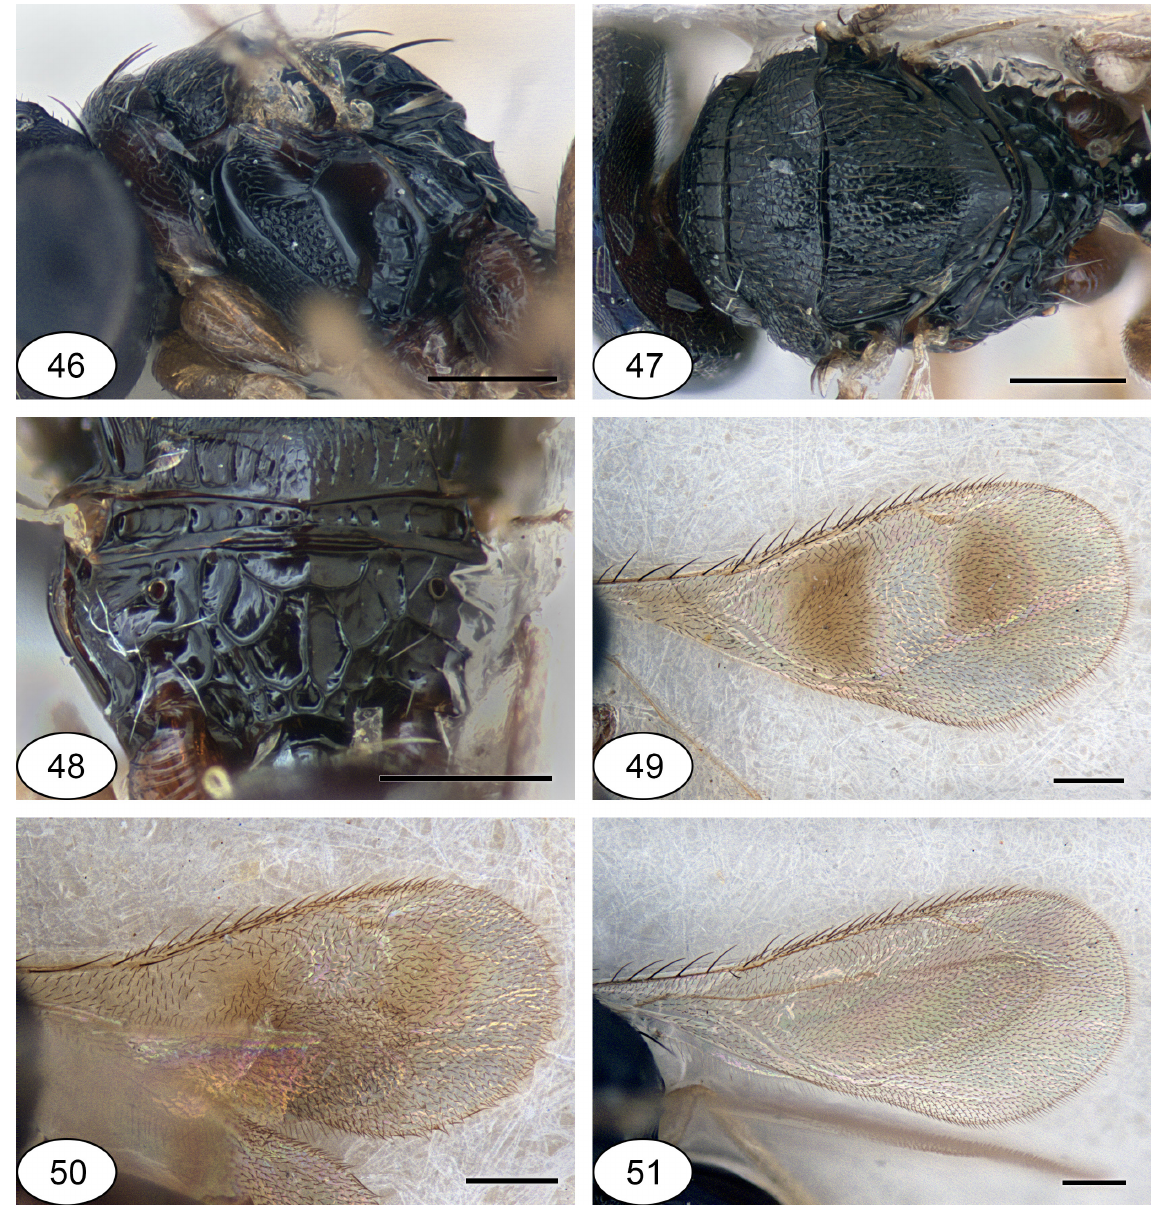
Figs 46–51. Netomocera cyanocephala sp. nov. 46 . Holotype, ♀, mesosoma, lateral view. 47 . Holotype, ♀, mesosoma, dorsal view. 48 . Holotype, ♀, propodeum, dorsal view. 49 . Holotype, ♀, fore wing. 50 . Paratype, ♀, fore wing. 51 . Paratype, ♀, fore wing. Scale bars: 0.2